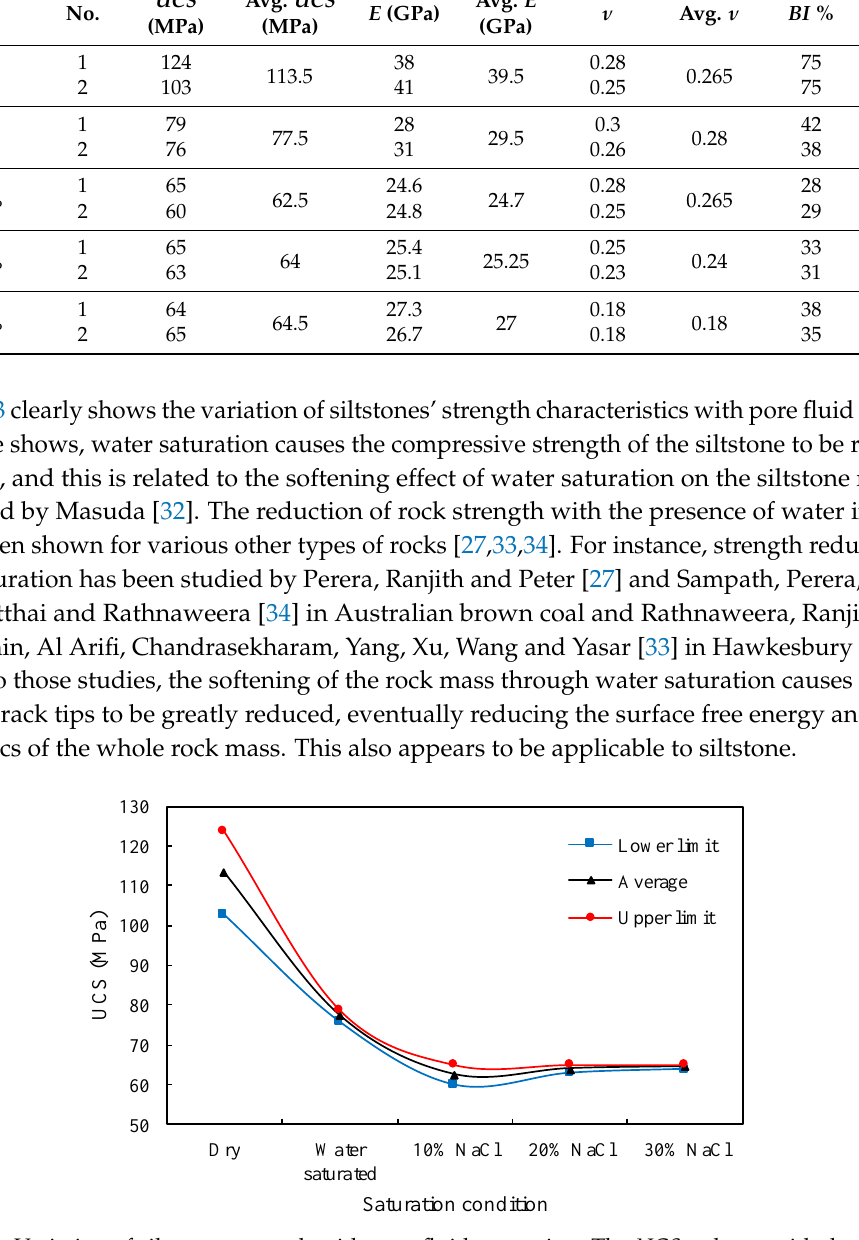
Figure 3. Variation of siltstone strength with pore fluid saturation. The UCS reduces with the water saturation and low NaCl concentrations, but higher order of NaCl concentrations cause a slight strength re-gain.